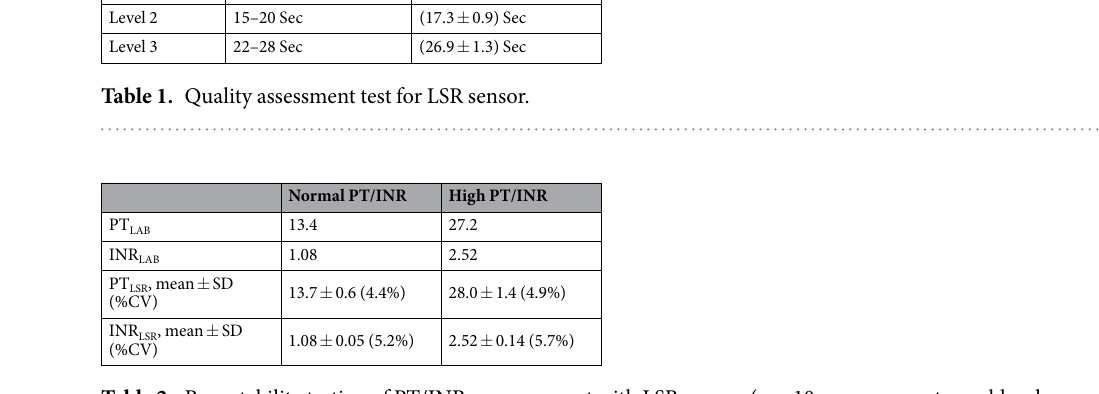
Table 2. Repeatability testing of PT/INR measurement with LSR sensor. (n = 10 measurements per blood sample, %CV was calculated by dividing the SD by